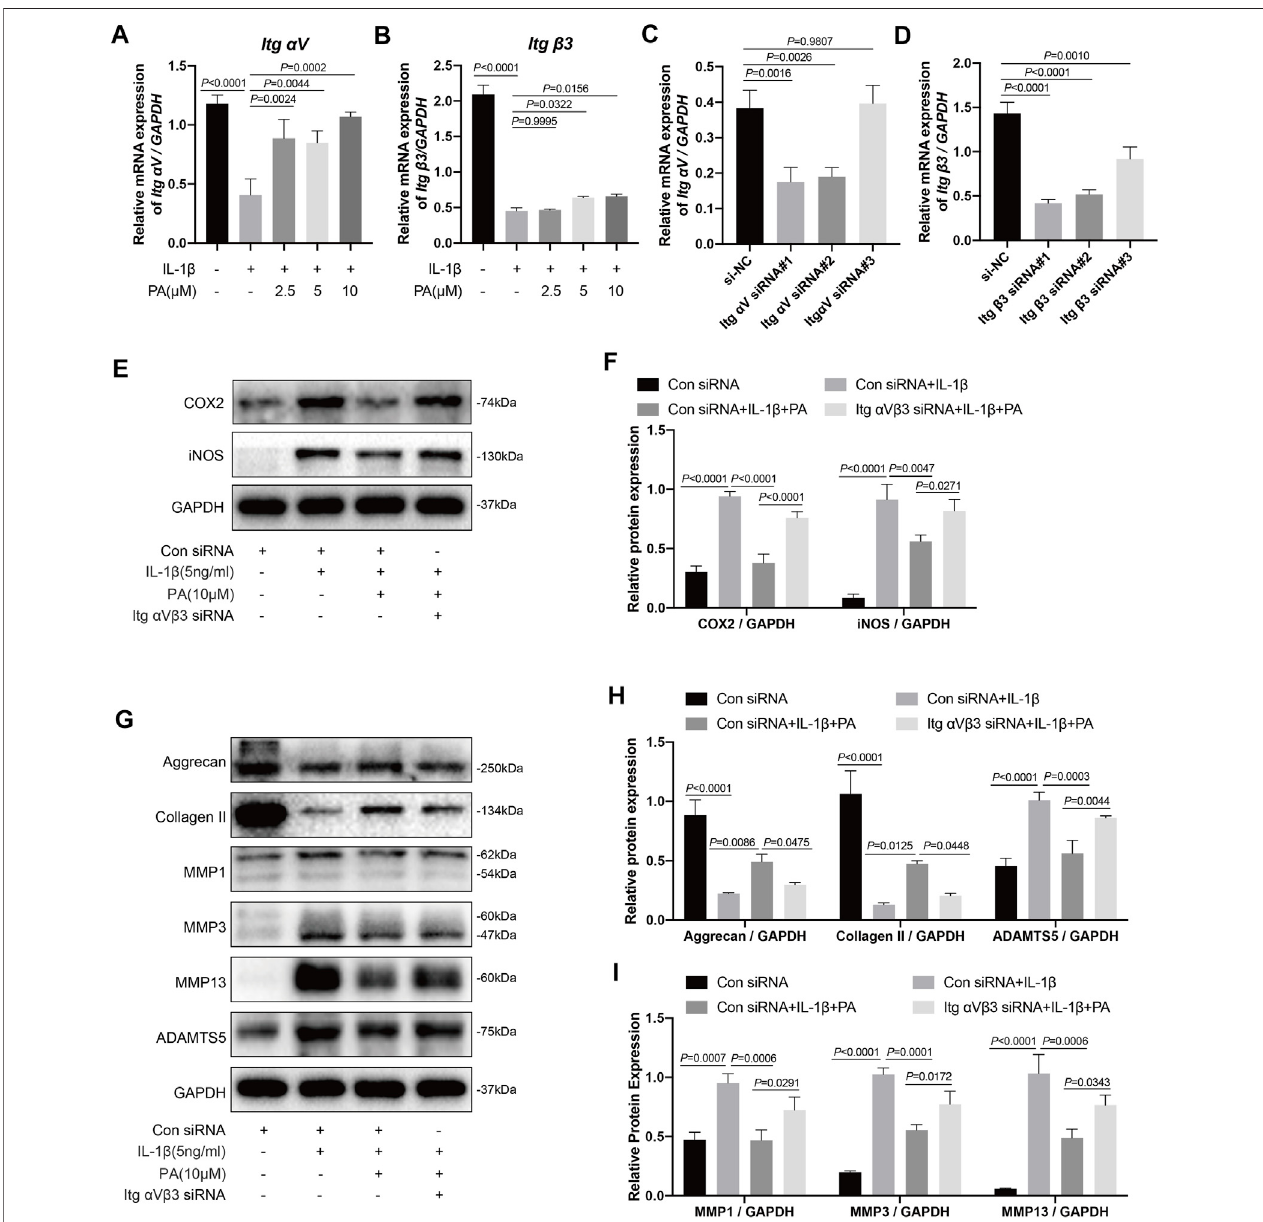
FIGURE 6 | Knockdown of integrin α V β 3 weakened the anti-in fl ammatory, anabolism enhancing, and catabolism inhibiting effect of PA on IL-1 β -induced chondrocytes. (A,B) Relative mRNA levels of integrin α V (Itg α V) and integrin β 3 (Itg β 3) in chondrocytes stimulated with 5 ng/ml of IL-1 β , alone or with PA (2.5, 5, and 10 μ M) for 24 h (C,D) Itg α V and Itg β 3 were knocked down by siRNA transfection, and the knockdown ef fi ciency was veri fi ed by RT-PCR. (E,F) In fl ammatory markers (COX2,iNOS)weredetectedbywesternblottingandthebanddensityofproteinlevelswerequanti fi edaftermicechondrocyteswereaddedwithorwithout5 ng/ml of IL-1 β , 10 μ M of PA, and Itg α V β 3 siRNA. (G – I) Western blotting was applied to measure the anabolic (aggrecan, collagen II) and catabolic markers (MMP1, MMP3, MMP13,andADAMTS5)intheItg α V β 3-de fi ciencymicechondrocytesalongwithorwithouttheadministrationof5 ng/mlofIL-1 β and10 μ MofPA,andthebanddensity of these protein levels were quanti fi ed in the histogram. GAPDH was used as an internal reference. Data are presented as means ± SD ( n (cid:1) 3). The exact p value was marked in the corresponding fi gure and p < 0.05 was considered statistically signi fi cant.